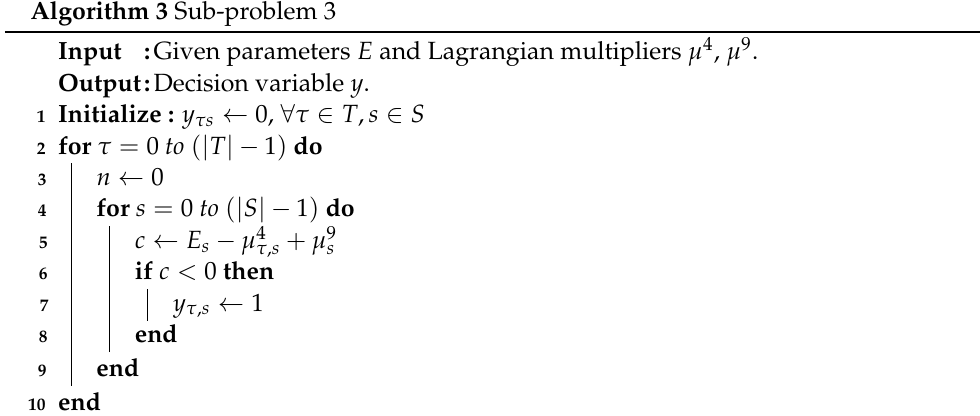
Algorithm 3 Sub-problem